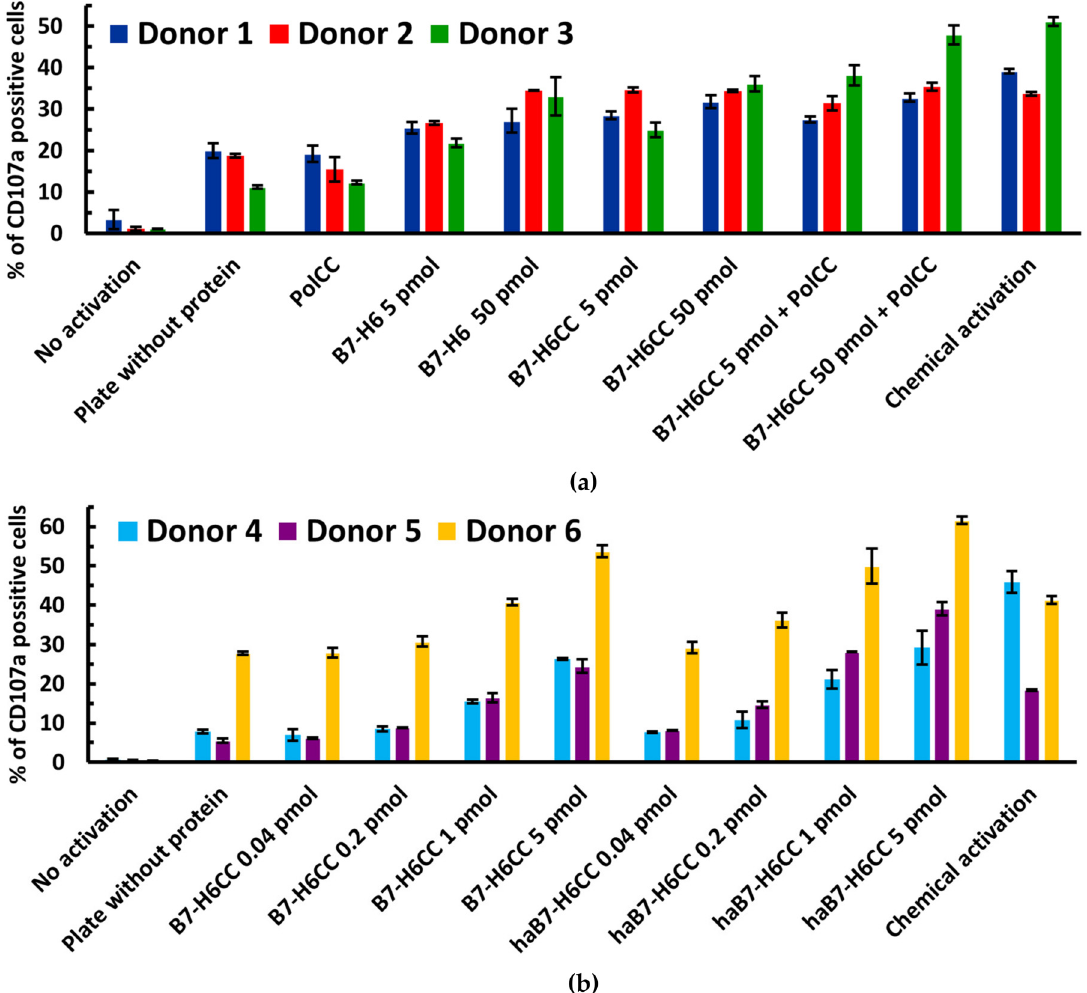
Figure 4. Both B7-H6 and B7-H6CC activate NK cells in the plate activation assay. ( a ) NK cells were incubated in various conditions with B7-H6, B7-H6CC, and polymer–protein complexes and in the control conditions. ( b ) Comparison between activation potential of B7-H6CC and haB7-H6CC proteins. Activation of NK cells was assessed with flow cytometry as the surface expression of CD107a molecule, an NK cell degranulation